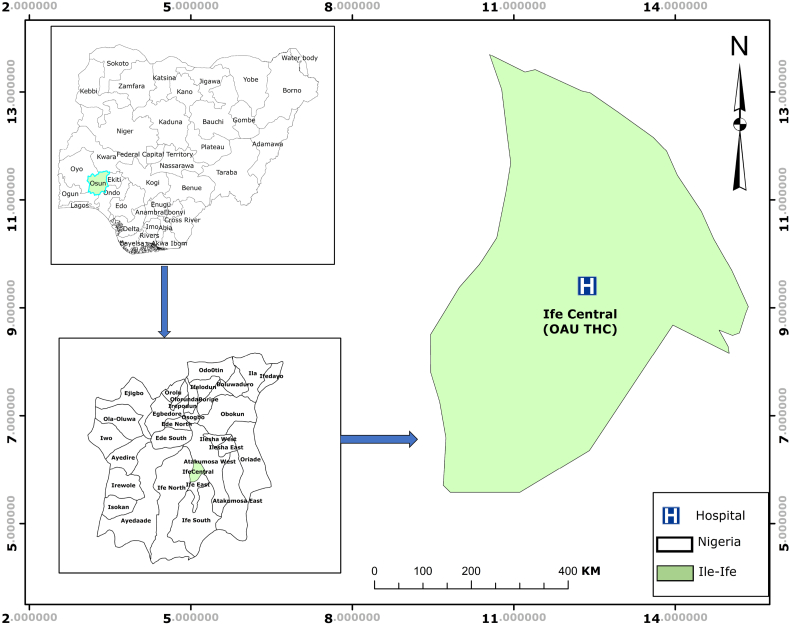
The Study Location.